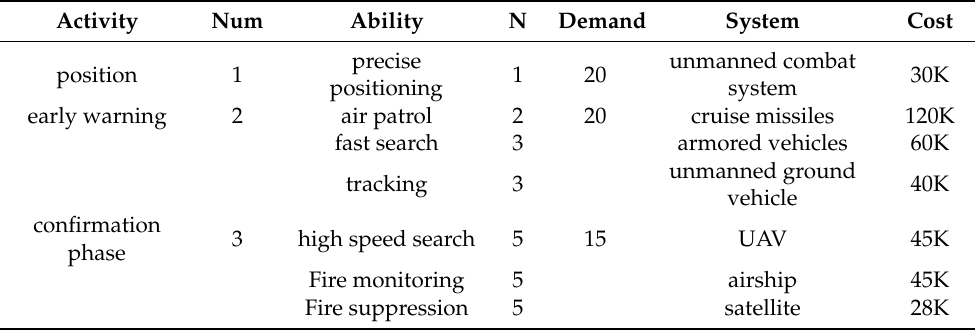
Table 1. Swarm performance unit.